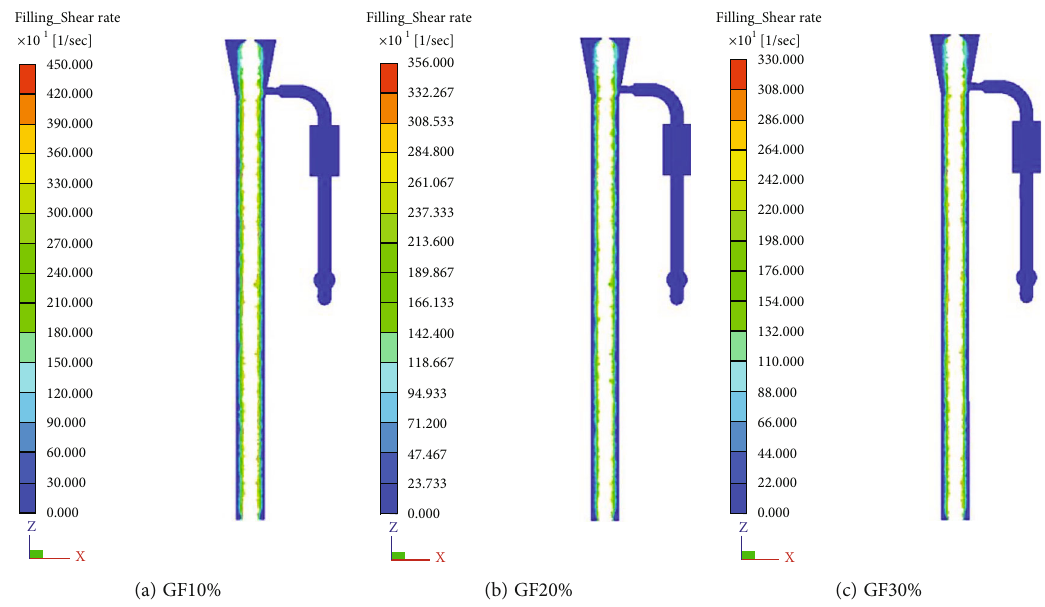
Figure 4: Shear rate distribution of di ff erent fi ber mass